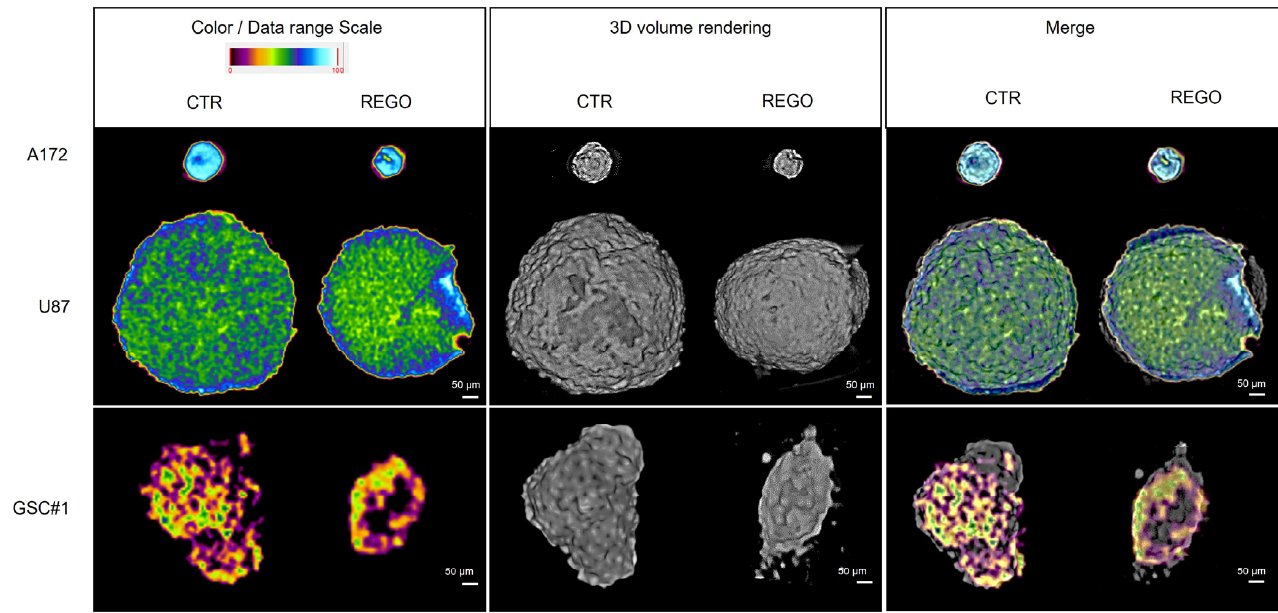
Figure 7. MicroCT analysis of 3D tumor spheroids. Left panels show the sectioning of spheroids in the central transverse plane. Samples were treated with a contrast agent and the color/data range scale indicates the difference in density related to the contrast absorption rate. Middle panels show the three-dimensional images of spheroids, highlighting, in particular, the spheroids’ outer surface. All regorafenib-treated spheroids are modified in shape and angularity compared to control spheroids. Scale bar: 50 μ M; resolution of 4.8 μ M voxel/size.